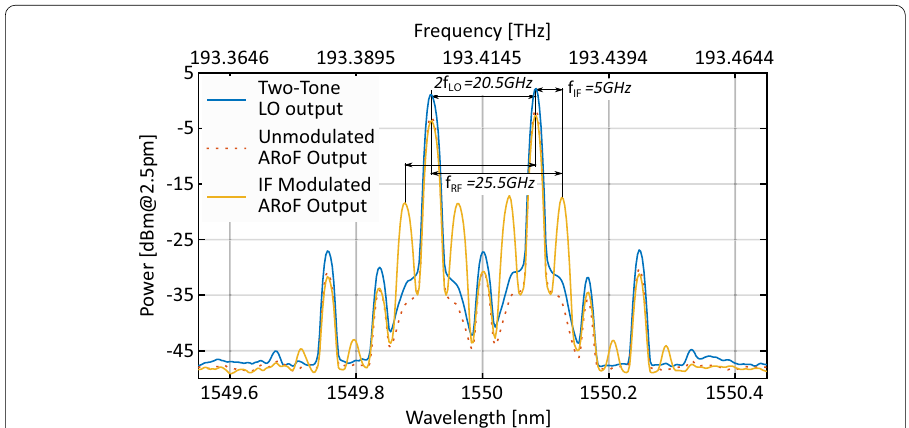
Fig. 5 Measured optical spectra of the signals generated by the ARoF transmitter: the plain two-tone signal output used for the remote-fed LO, the ARoF signal before and after modulation with the IF